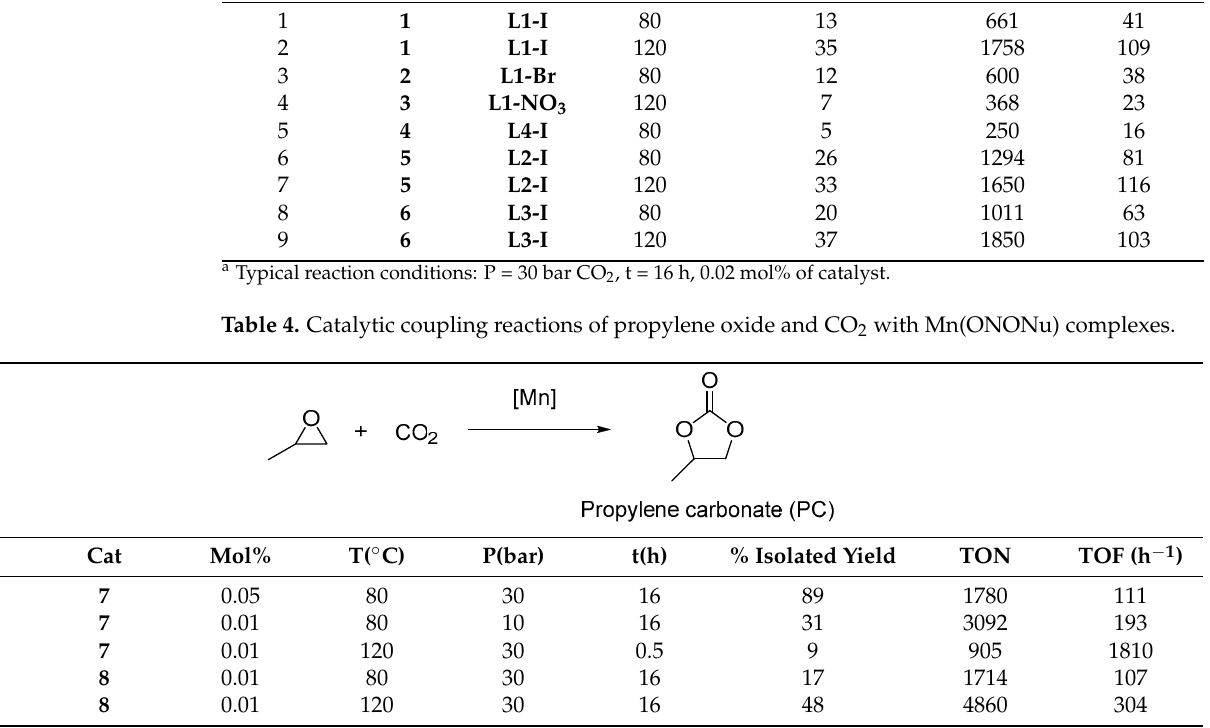
2 with Co(ONONu) complexes a .